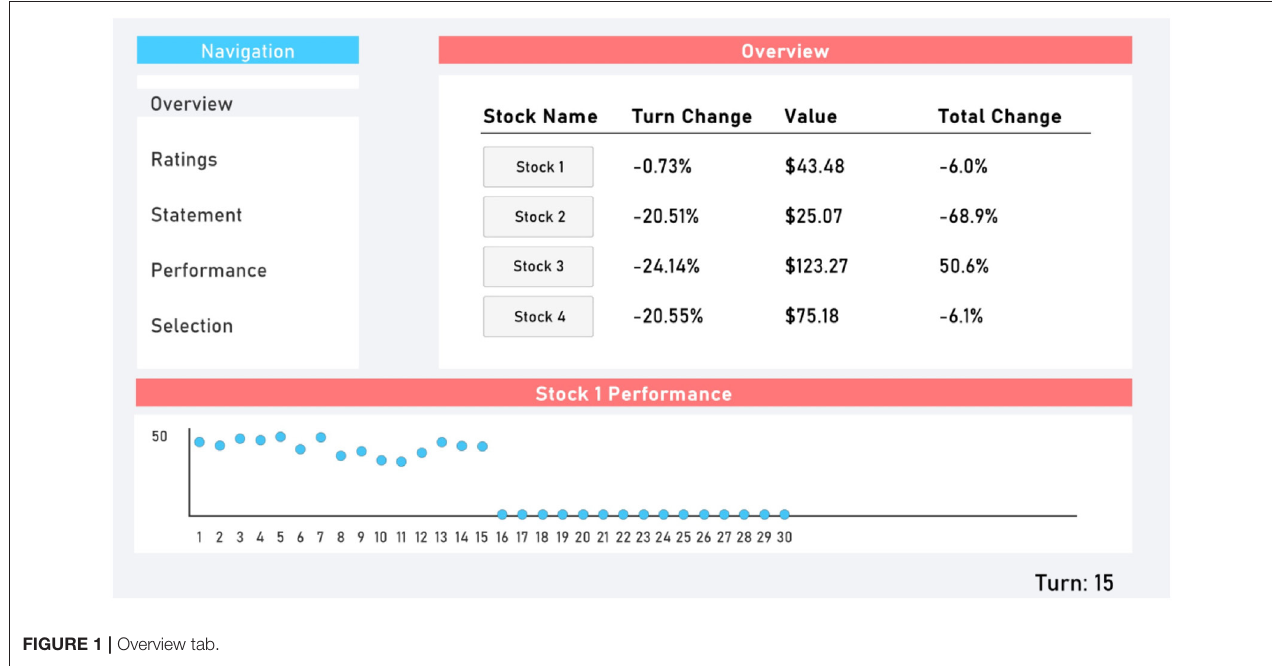
FIGURE 1 | Overview